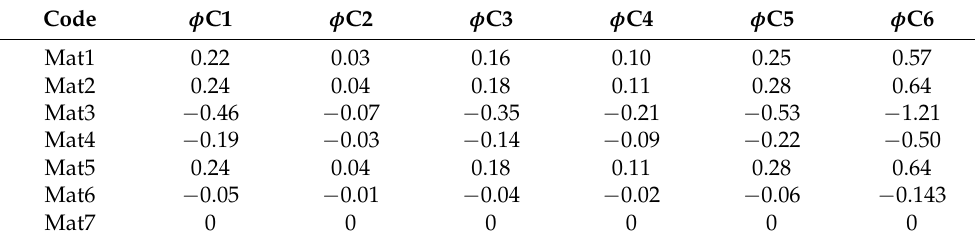
Table 17. Matrix net flow of exceeding PROMETHEE II.